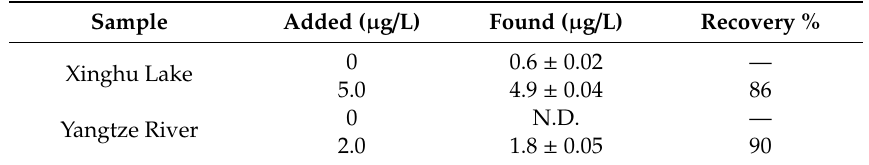
Table 3. Determination of Cd(II) in water samples (sample volume: 100 mL, final volume: 10 mL, n = 3).